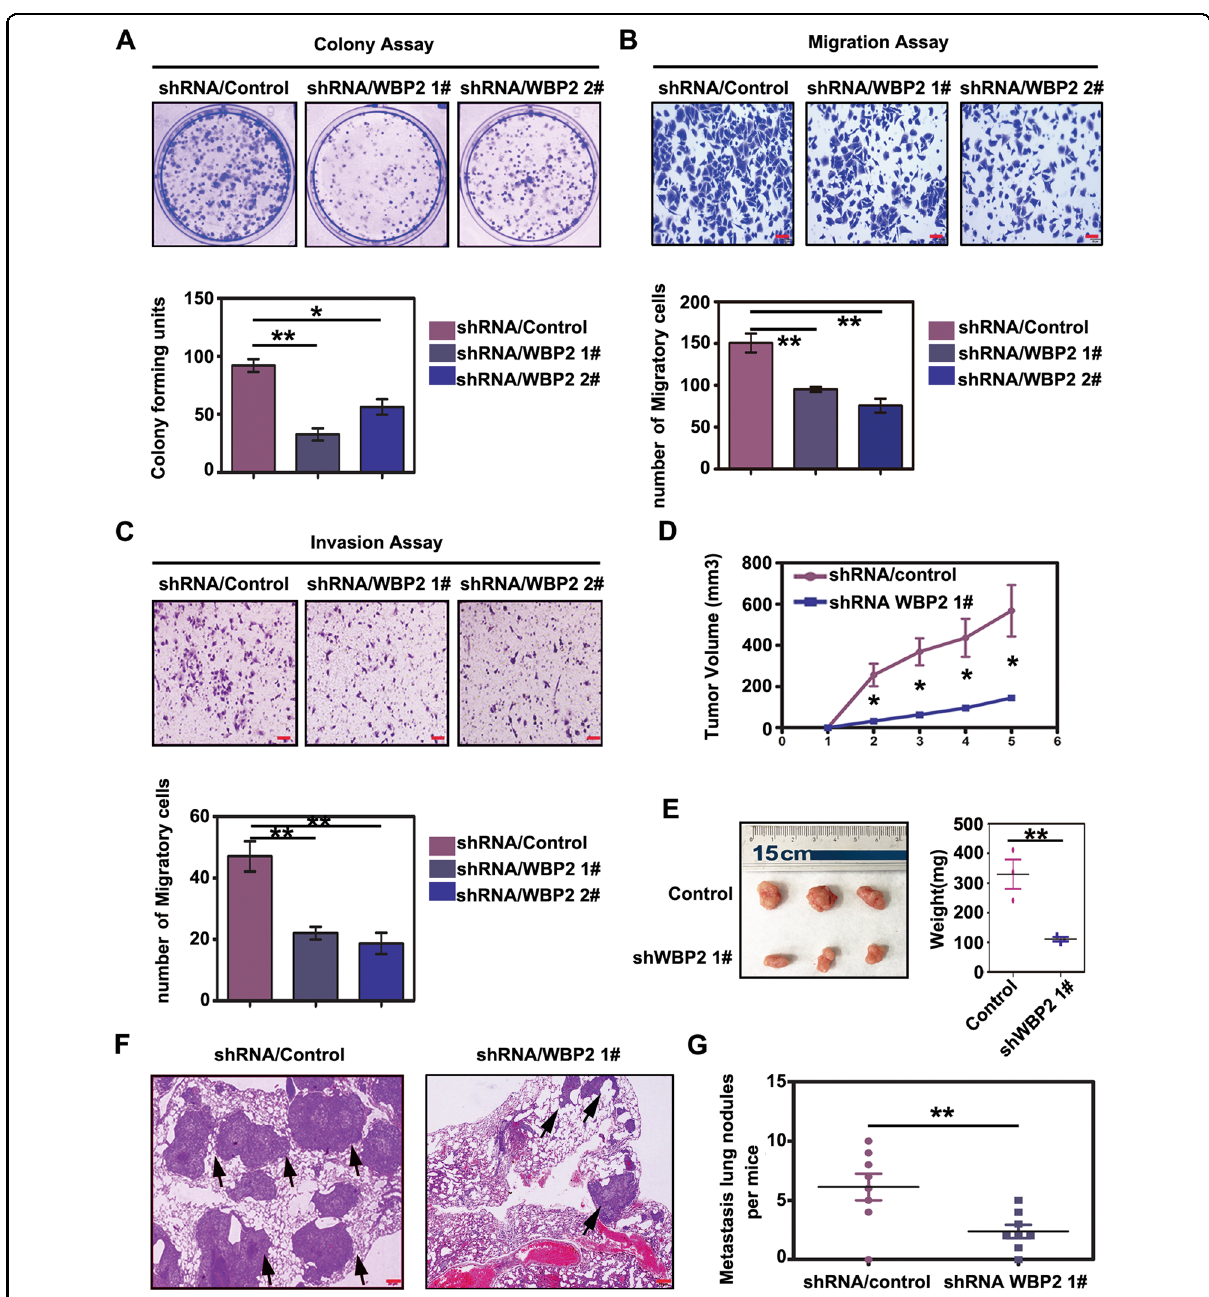
Fig. 3 Knockdown of WBP2 weakens the proliferation, invasion, and metastatic abilities of lung cancer cells. Lentivirus-coated shRNA-WBP2 was added to the A549 cell line, and stable cells with WBP2 knockdown were screened for use of puromycin (5 μ g/mL). The colony-forming and Transwell assay results reveal that the reduction in WBP2 protein signi fi cantly weakens proliferation ( A control vs shWBP2-1 vs shWBP2-2: 92 ± 5 vs 32 ± 5 vs 56 ± 6, P < 0.05), migration ( B control vs shWBP2-1 vs shWBP2-2: 150 ± 11 vs 75 ± 8 vs 95 ± 2, P < 0.01), and invasiveness ( C control vs shWBP2-1 vs shWBP2-2: 47 ± 5 vs 22 ± 2 vs 18 ± 3, P < 0.01) of lung cancer cells. In vivo: subcutaneous tumor transplantation and lung metastasis experiments via tail vein injection in nude mice reveal that volumes and weights of subcutaneously transplanted tumors in nude mice are signi fi cantly decreased ( D , E control vs shWBP2-1: volume: 568.0 ± 125.3 vs 145.0± 9.3 [mm 3 ], P < 0.05; weight: control vs shWBP2-1: 330.3 ± 49.2 vs 111.3± 7.5 [mg], P < 0.05), and the number of lung cancer metastasis foci is also signi fi cantly reduced ( F , G control vs shWBP2-1: 6.1 ± 1.1 vs 2.4 ± 0.6, P < 0.01). P < 0.05 indicates statistical signi fi cance, * P < 0.05, ** P <